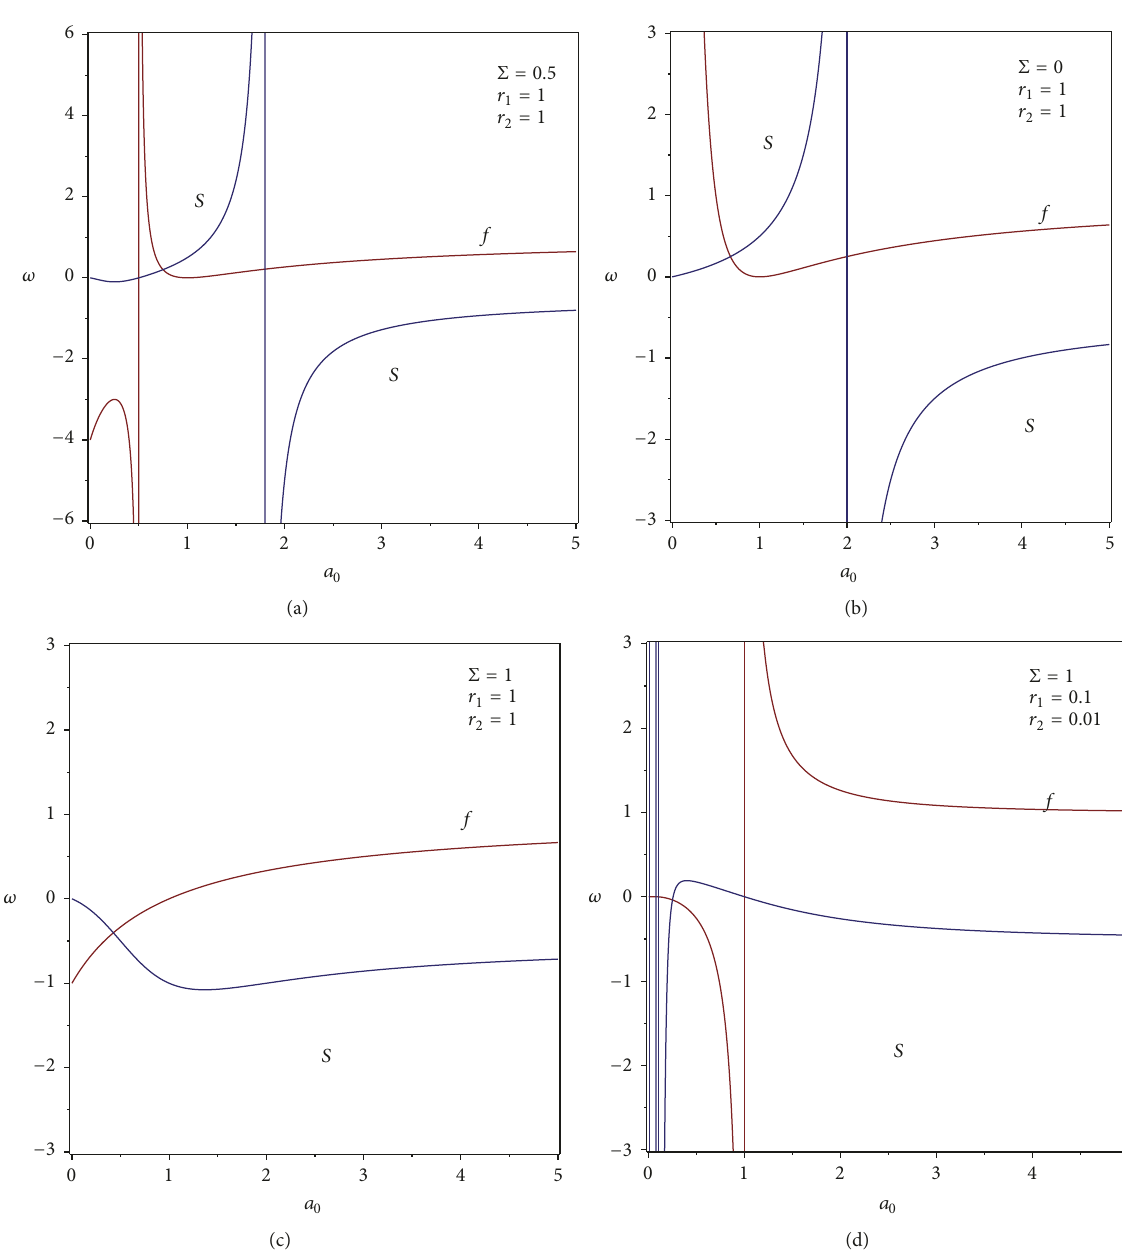
Figure 1: Stability regions of DTSW in terms of 𝜔 and radius of the throat 𝑎 0 for different values of Σ , 𝑟 1 , and 𝑟 2